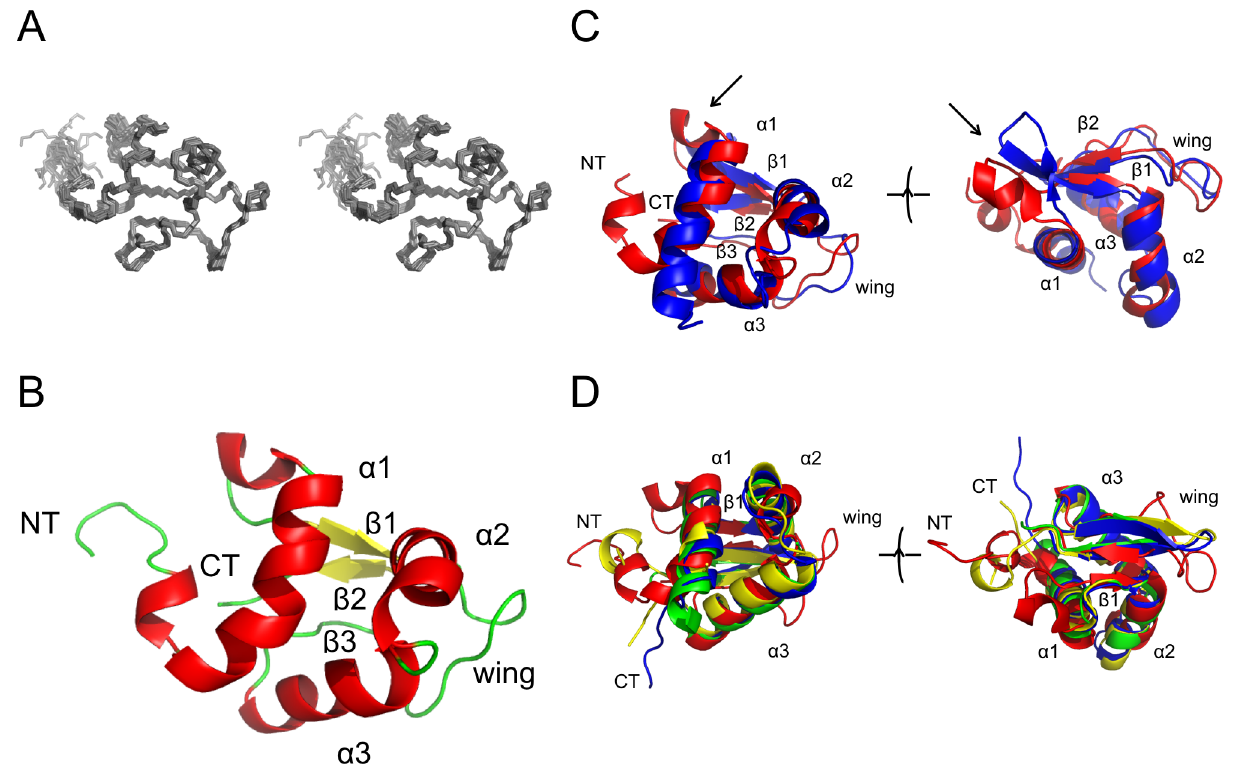
Fig 1. Structure determination of rat ABD2. A: Stereo view of the family of the best 20 structures superimposed on the lowest energy structure. B: Secondary structure of the lowest energy structure in the same orientation as in A. Key structural features are labeled, helices are coloured red and strands are coloured yellow. C: Structural superposition of Ms1 ABD2 (red, PDB ID 2KRH) and COSTARS (blue, PDB ID 2L2O). Shown in the same orientation as in B as well as rotated about 90° around the horizontal axis to reveal the structural differences in the segment connecting α 1 and β 1 (arrow). D: Structural superposition of Ms1 ABD2 (red) on the three top hits of the DALI search in the PDB (1HR3 (green), 1SAX (blue), 1SD4 (yellow); for a list of the top 50 DALI hits see S3 Fig).